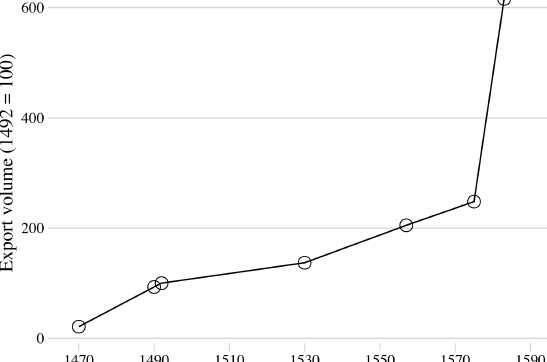
Figure 13. Quarterly prices in Kraków. Source: Pelc (1935).